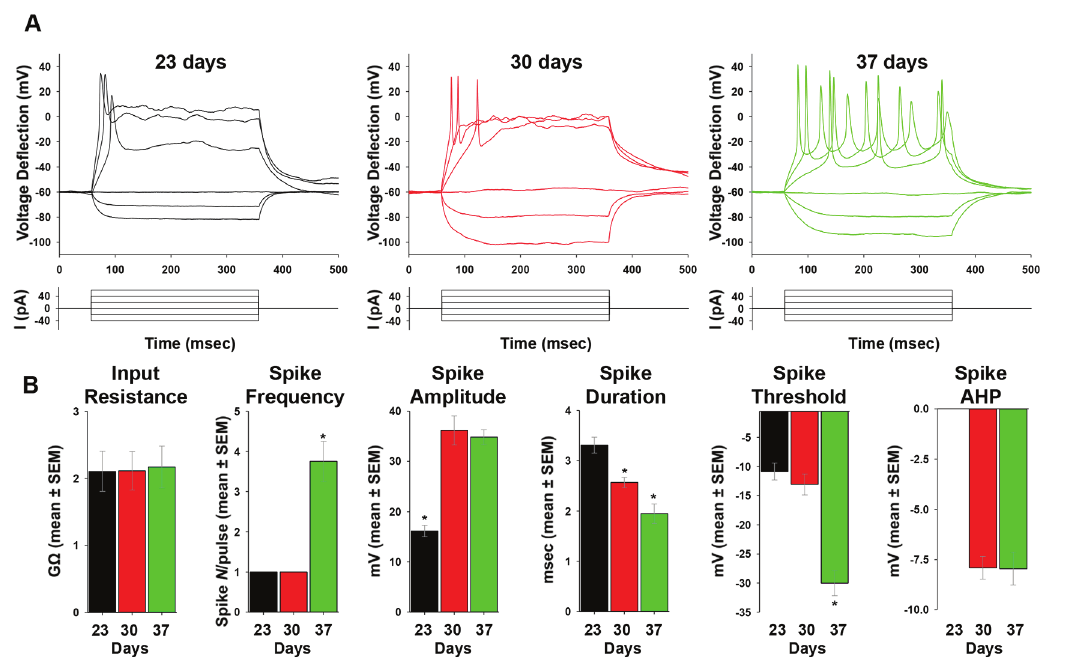
Figure 2. Current clamp recordings of hESCs-derived neurons. ( A ) Representative traces for current clamp recordings at day 23 (black), 30 (red) and 37 (green). Membrane potential was held at ~-60 mV and voltage deflections (mV) are shown following 6 consecutive pulses of ~20 pA current injection from -40 to +60 pA. ( B ) Data analysis showing (from left to right): input resistance (G Ω ), spike frequency (spike number per pulse), spike amplitude (mV), spike duration (msec), spike threshold (mV) and spike after hyperpolarization (‘AHP’, mV), for the same recordings days as in ( A ). Sample size: n=21 at day 23; n=25 at day 30; n=23 at day 37. Values are mean ± SEM. *P<0.05,